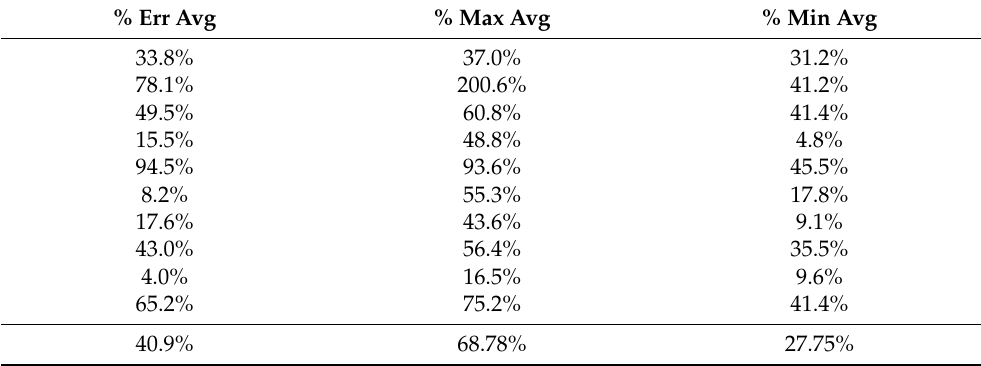
Table A9. Set 1, trials 1–10 data (single 0.5 PR value).